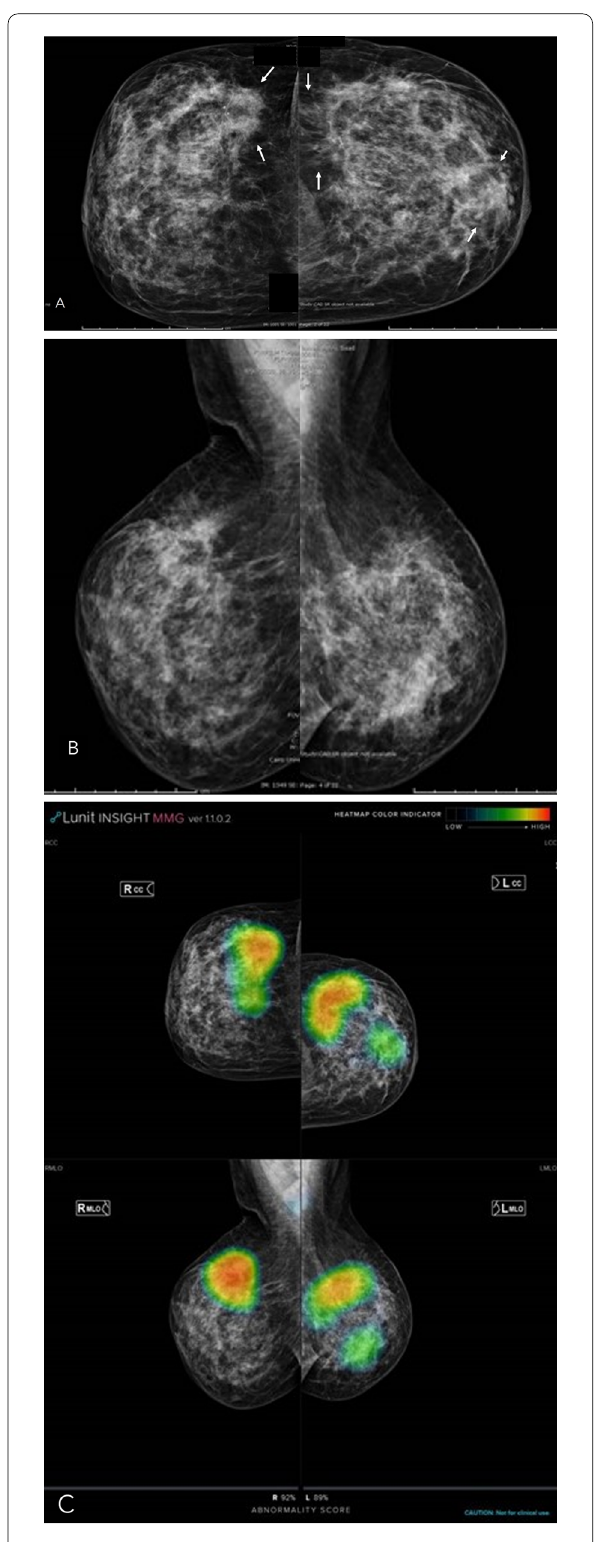
Fig. 2 A 43-year-old female patient presenting with mastalgia. A , B Digital mammography in cranio-audal and mediolateral oblique views respectively of both breasts. They show extremely dense breasts (ACR d) with asymmetries and subtle distortions (arrows). C AI: showing right breast large UOQ suspicious area with 92% score of malignancy. The left breast also shows UOQ as well as retro areolar suspicious areas, with 89% score of malignancy. Both breast lesions elicit red and green heat maps which reflected high probability of malignancy on the color-coded scale. Ultrasound guided True-cut biopsy was performed and revealed bilateral ILC. In this case AI was able to illustrate the disease bilaterality and multicentricity on the left side which was not evident on mammography